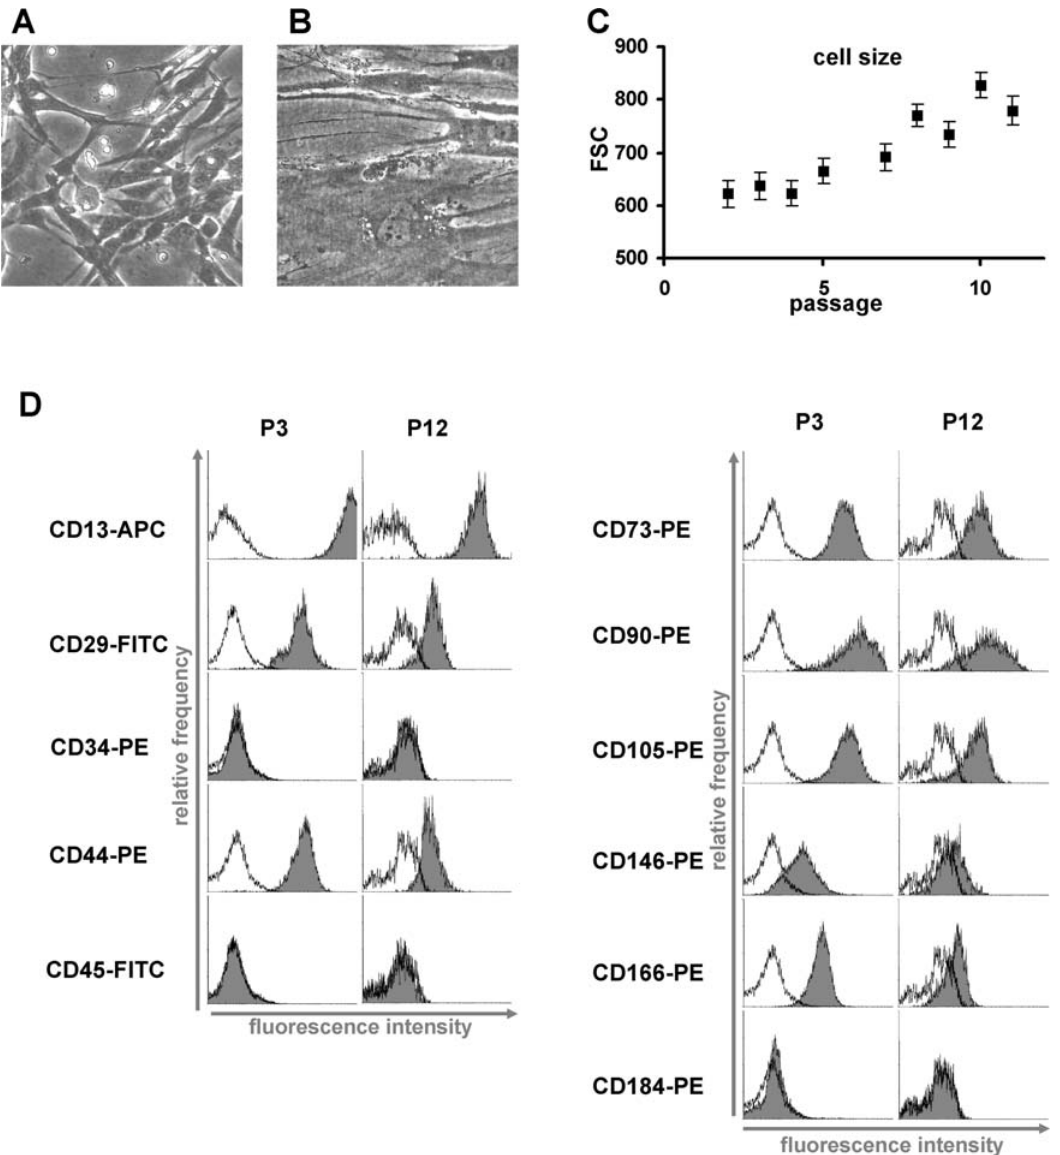
Figure 2. Morphologic changes and immunophenotype upon senescence. Replicative senescence is reflected by dramatic changes in morphology. Cells enlarge, generate more vacuoles and cellular debris and ultimately stop proliferation. Representative morphology of MSC in early (P3) and senescent passage (P12) is presented (A, B). The continuous increase in cell size and granularity is reflected by the increasing forward-scatter signal in flow cytometry (FSC, 6 SD; C). Immunophenotypic analysis of all MSC preparations was in accordance with the literature whereby the detection level for positive markers was much higher in early passages compared to late passages (black line = autofluorescence; D). A representative analysis of three preparations is